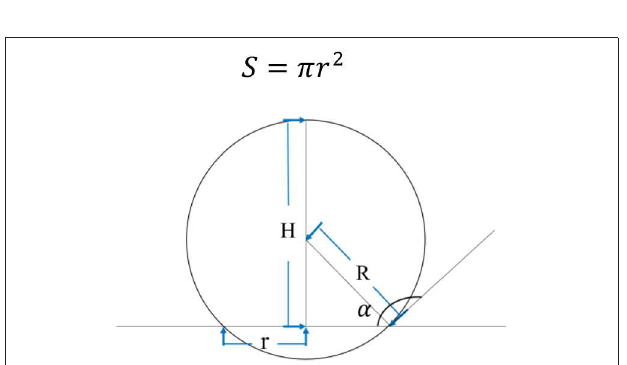
FIGURE 3 | Schematic diagram of the shape of a droplet on the